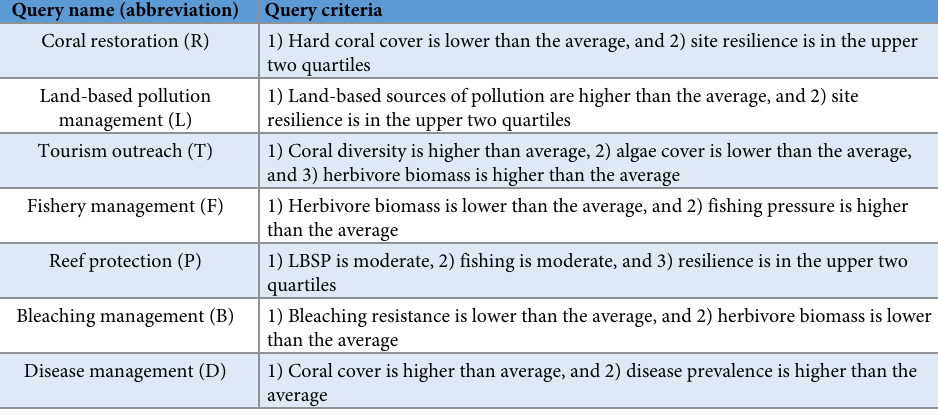
Table 2. Management action queries based on resilience indicators, resilience scores, and stressors. Not all queries use all three types of